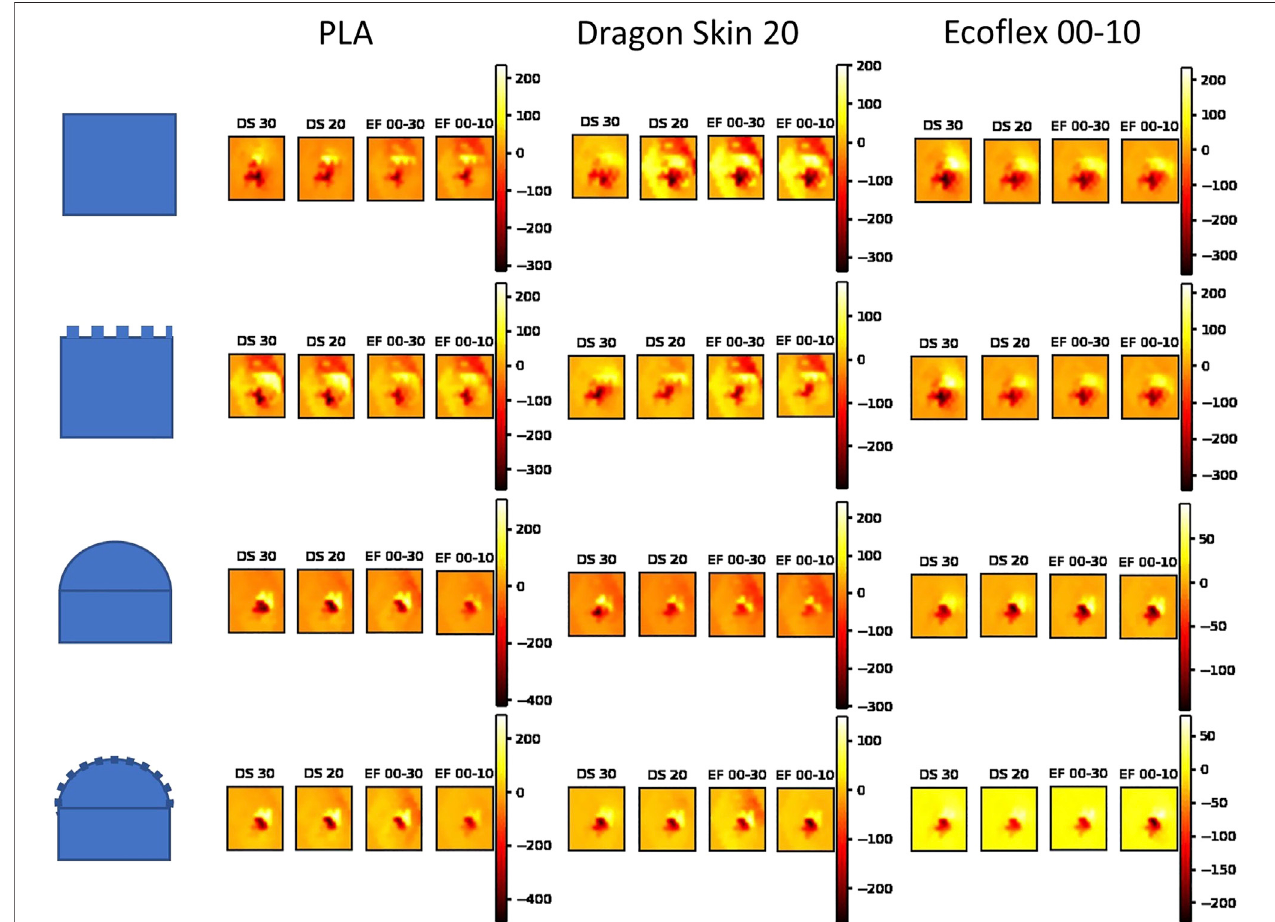
FIGURE 5 | Raw tactile data as a function of fi lter ’ s material, and test object ’ s material, shape, and texture. Tactile images are taken after 2.5 s of the touch phase, performed as described in Section 2.2 . For displaying purposes, Dragon Skin is abbreviated DS and Eco fl ex as EF.